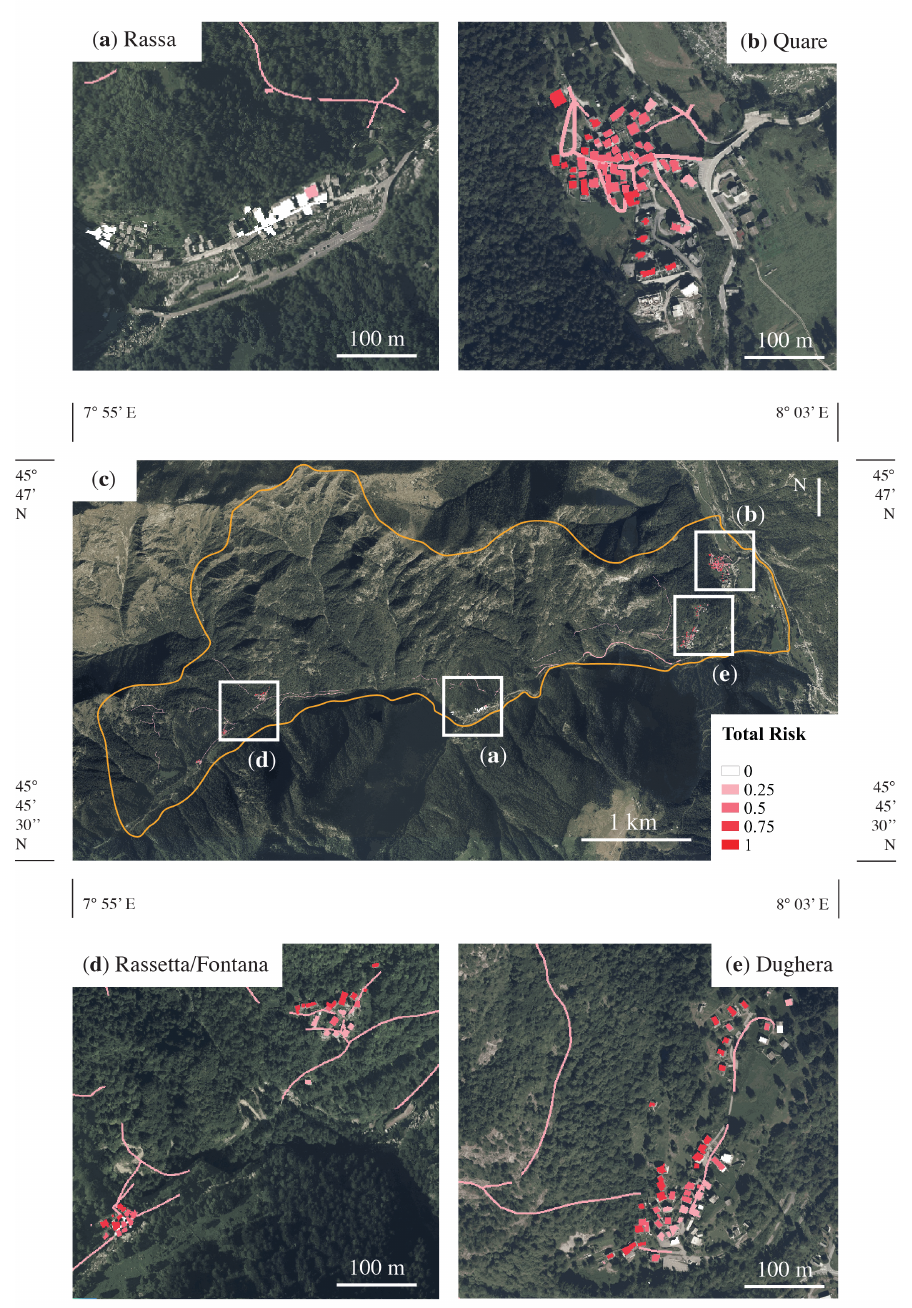
Figure 11. Maps of the total risk for the 1 m 3 scenario: ( a ) zoomed view of the village of Rassa; ( b ) zoomed view of the village of Quare; ( c ) general map of the entire valley; ( d ) zoomed view of the villages of Rassetta and Fontana; ( e ) zoomed view of the village of Rassa. At the macroscopic scale, the difference between the three scenarios is barely visible, whereas, in the zoomed images, the three risk maps are clearly distinguished. Figure 12 shows the results related to the three scenarios for the hamlets of Quare and Dughera; as expected, the lower mass is associated with the lower